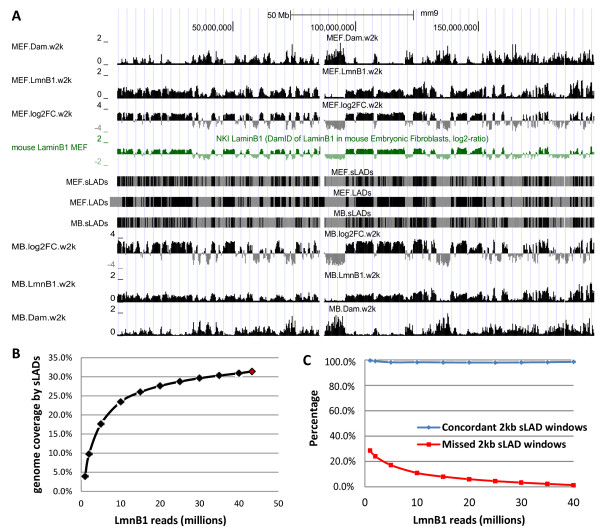
sLADs/LADs in MEFs and myoblasts (MB). (A) Chromosome 1 is presented in UCSC genome browser (see Additional file 2: Figure S1 for the entire map; [30]). Tracks “Dam.w2k” and “LmnB1.w2k” plot read densities (RPKM) in non-overlapping, contiguous 2 kb windows along the chromosome. Similarly, the track “log2FC.w2k” plots log2 RPKM ratios of LmnB1 over Dam at a 2 kb resolution. The track “mouse LaminB1 MEF” is taken from the published data [15] which plots the log2 fluorescent signal ratio of LmnB1 over Dam for each microarray probe. Tracks “sLADs” and “LADs” depict the LADs/sLADs (black regions), non-LADs/non-sLADs (grey regions) and undetermined regions (blank regions). (B) Estimate of sequencing depths. Random samples of various sizes are generated from 43.3 million of MEF LmnB1 reads, each with three replicates. The plotted genome coverage by sLADs at a sequencing depth is averaged from the three replicates. The red data point represents the result based on the full dataset of 43.3 million reads. (C) Estimate of concordance of sLADs identified at different sequencing depths. The sampled sequencing depths are the same set as (B). Concordant 2 kb sLAD windows are 2 kb windows that are identified as sLADs at both the given lower sequencing depth and the highest sequencing depth (the full dataset), and the corresponding percentage is to divide the number of concordant 2 kb sLAD windows by the total number of 2 kb sLAD windows identified at the given sequencing depth. Similarly, missed 2 kb sLAD windows are those identified as non-sLADs at the given lower sequencing depth but as sLADs at the highest sequencing depth, and the percentage is to divide the number of missed 2 kb sLAD windows by the total number of 2 kb non-sLAD windows at the given sequencing depth.